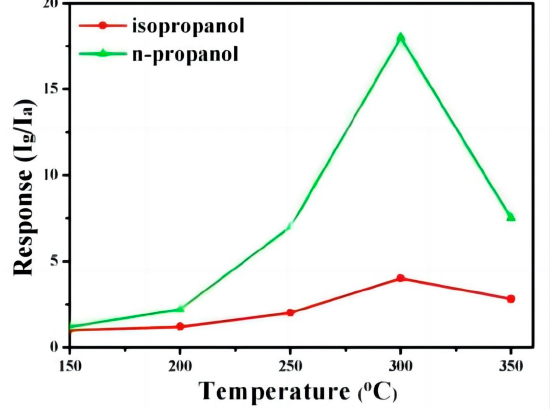
Figure 8. Responses of the GO/ZnO nanosheet composite sensor to 50 ppm isopropanol and n-propanol at different operating temperatures.